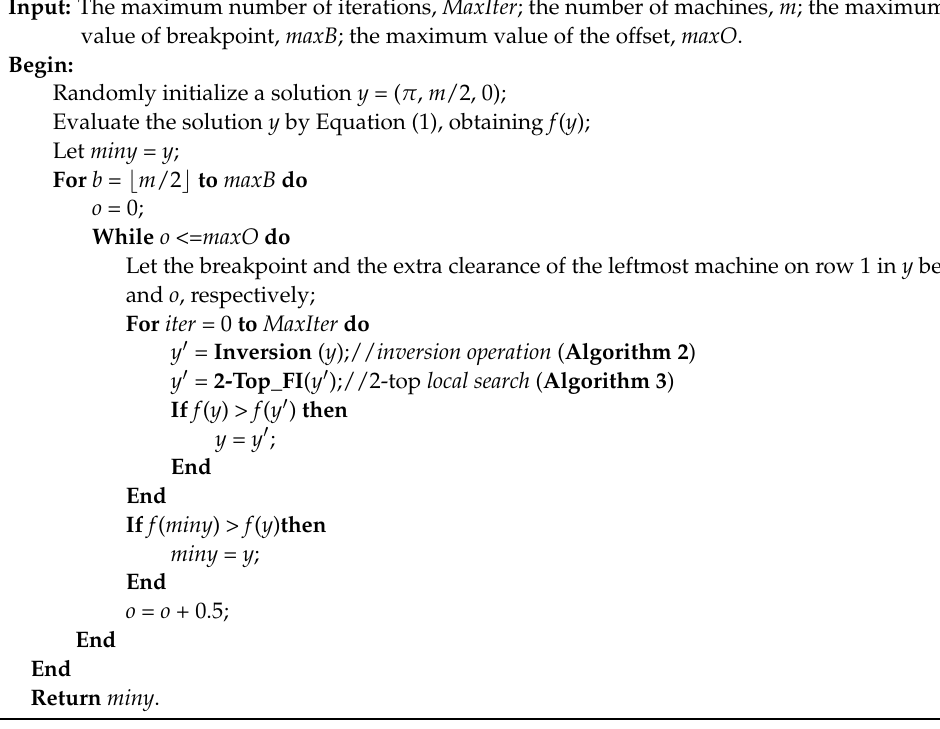
Algorithm 1. The pseudo-code of local search